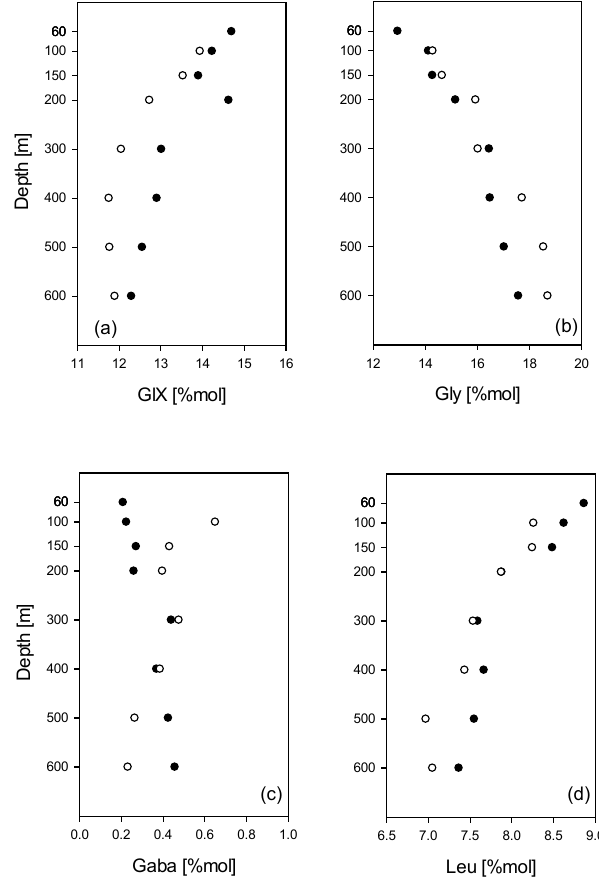
Figure 6. Molar percentages of selected amino acids contained in PHAA during the deployment of two STDT in the ETNA. Solid symbols are used for deployment no. 1 and open symbols for de- ployment no. 2.